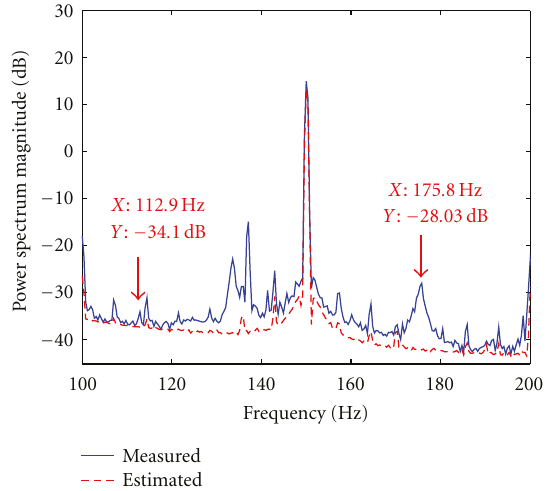
Figure 19: Power spectrum density of two currents: zoom between 100 and 200